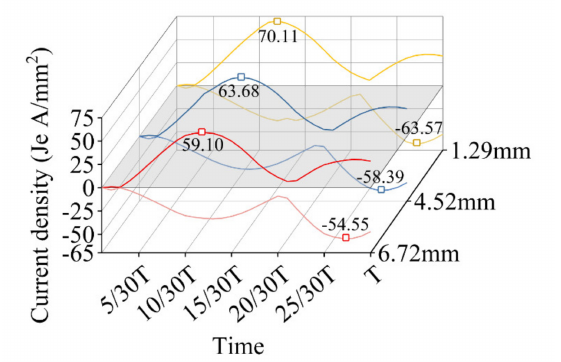
Figure 20. Maximum current density with notch height at 1000